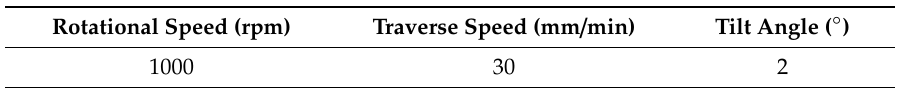
Table 1. FSW parameters .